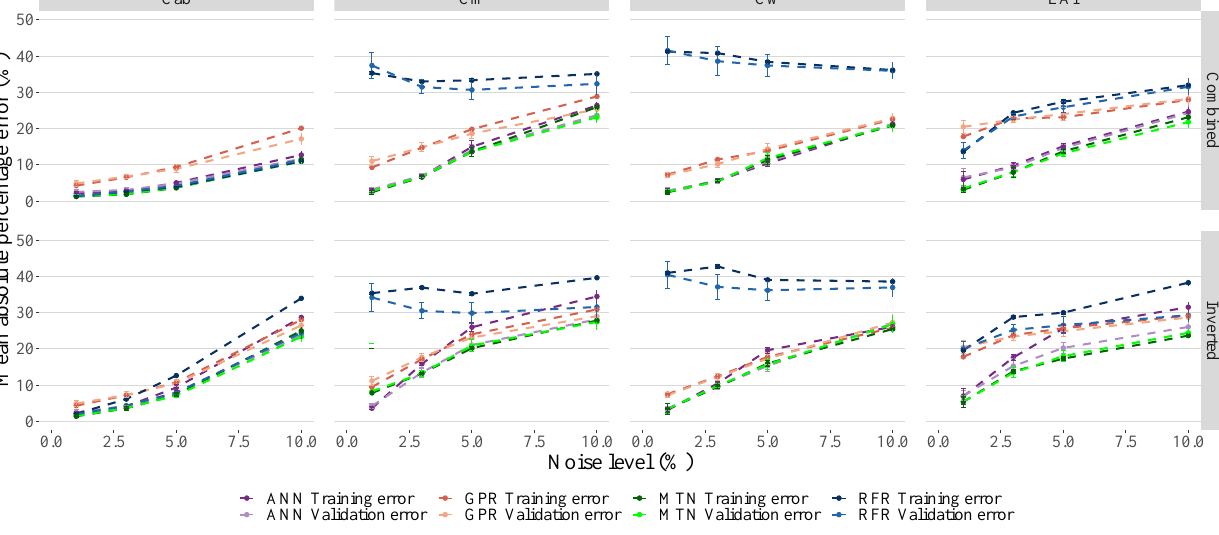
Figure 9. Detail of Figure 8 between 0 and 10% added